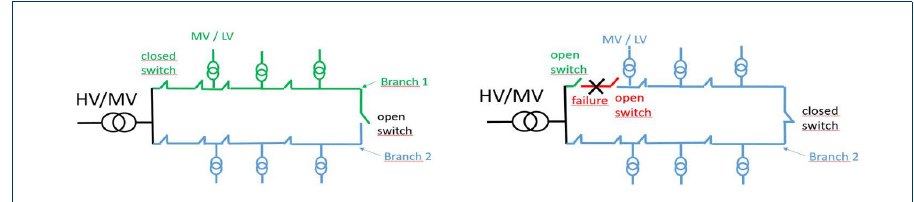
Figure 3 Initial schedules for B (top) and initial / accepted cumulative ones (bottom left / right)